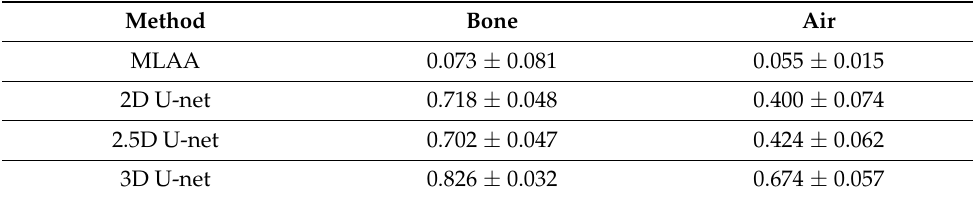
Table 1. Dice similarity coefficients with the CT-derived µ -map ( µ -CT).